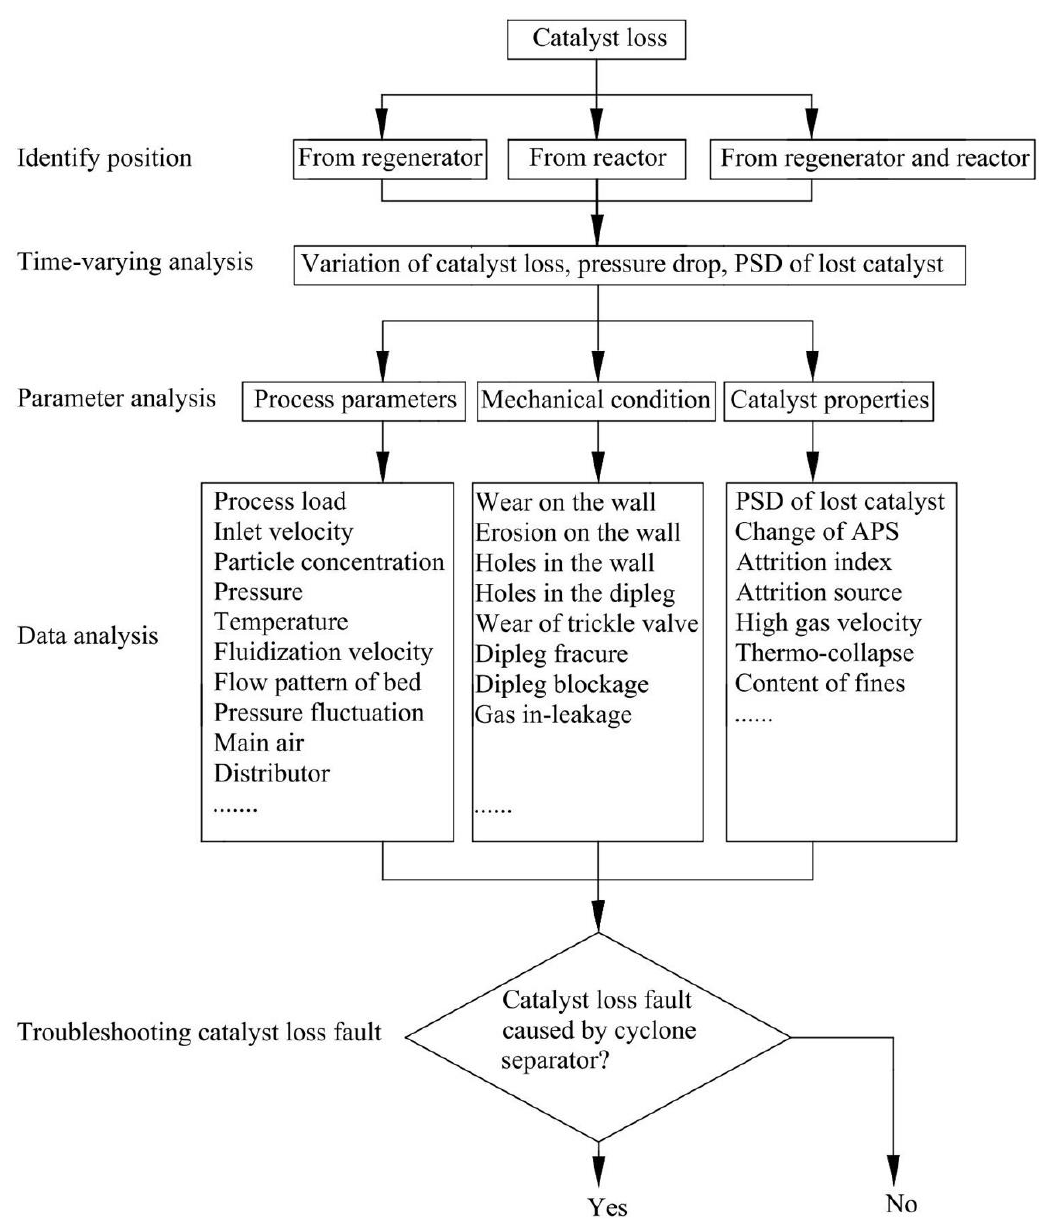
Figure 8. A stepwise diagnosis method for catalyst loss